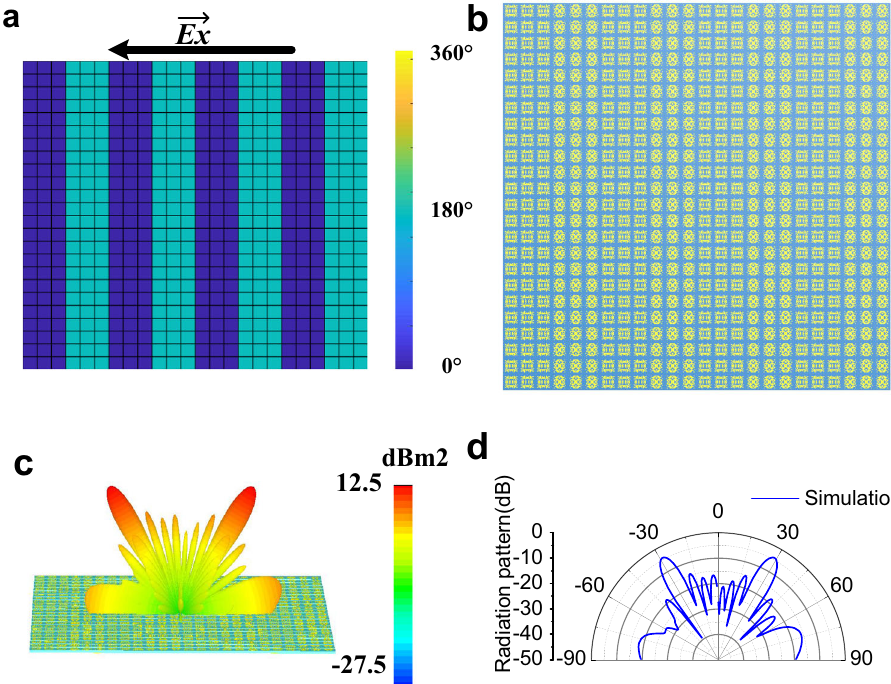
Fig. 5 The simulation of abnormal re fl ection. a 2D phase distributions of abnormal re fl ection. b Pattern of the focusing metasurface generated monolithically by the trained transfer learning model according to phase pro fi le. c The 3D far- fi eld result of this metasurface. d The cross pro fi le of far- fi eld result in θ =